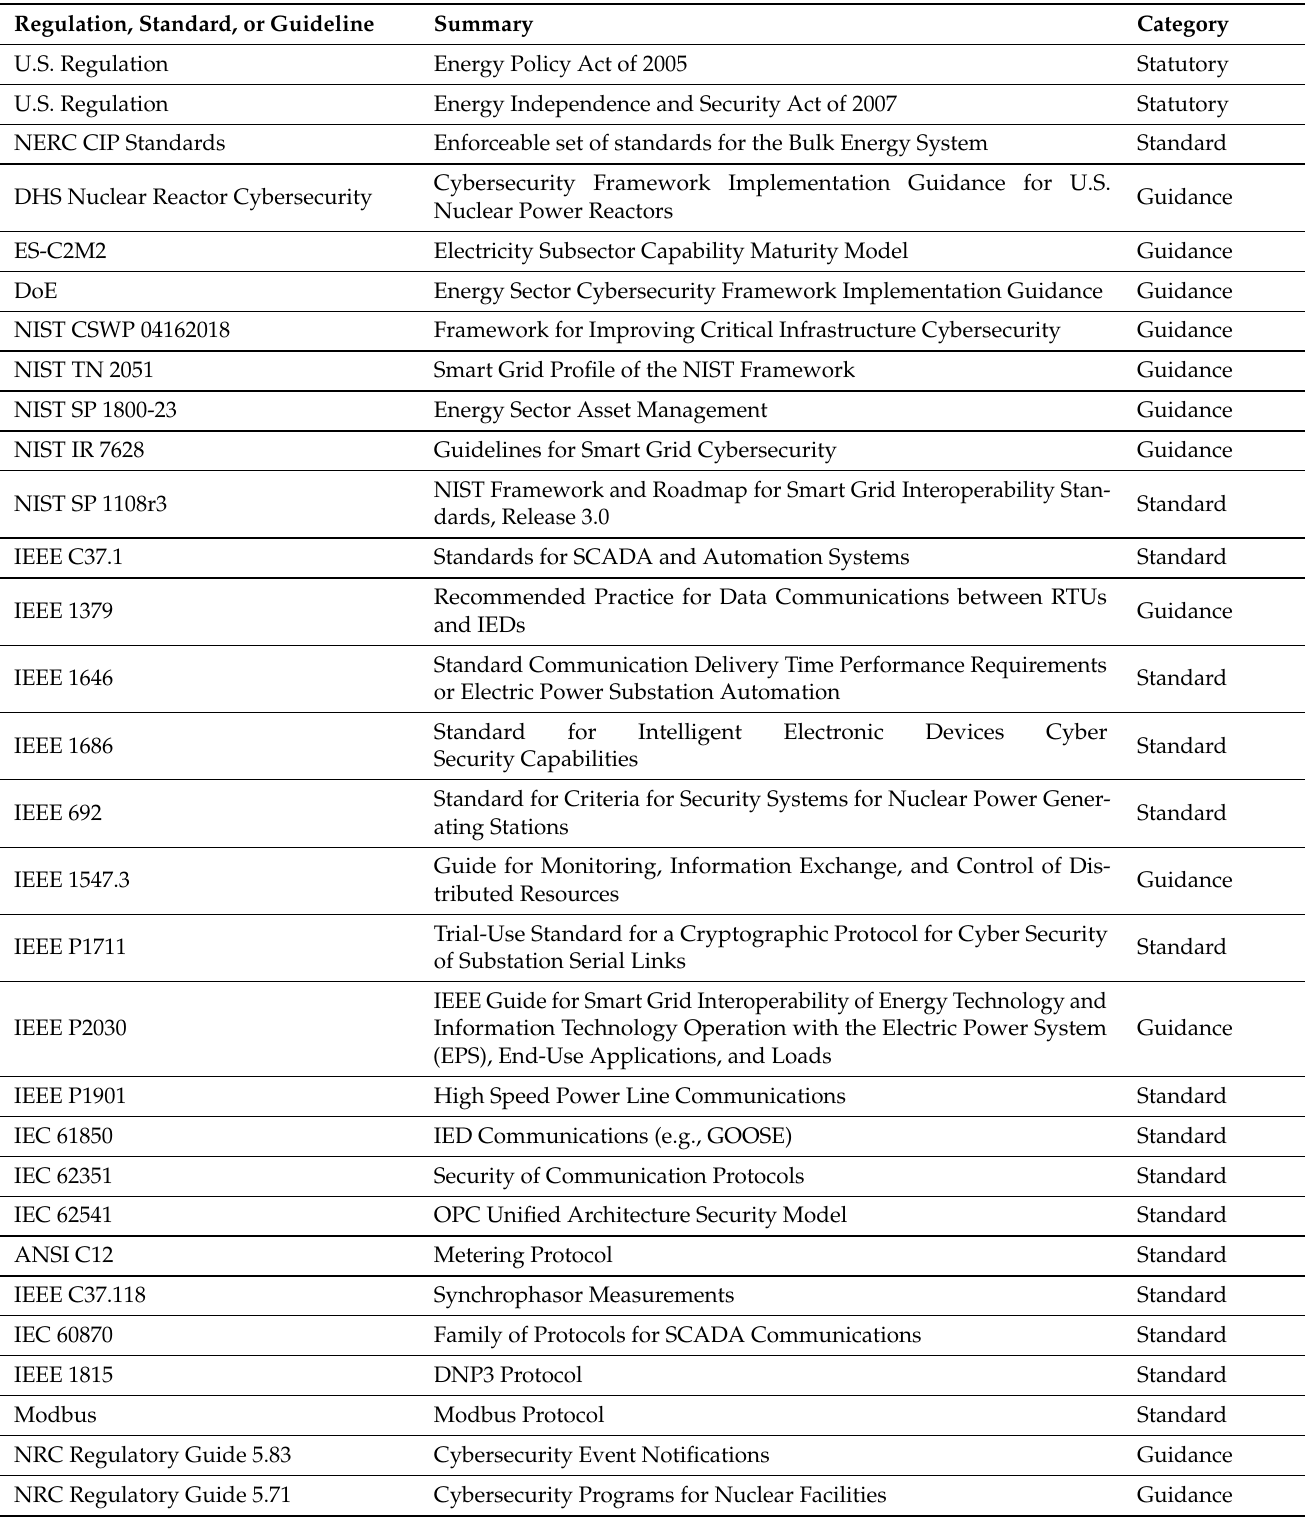
Table 1. Summary of Regulations, Standards, and Guidance for the U.S. Energy